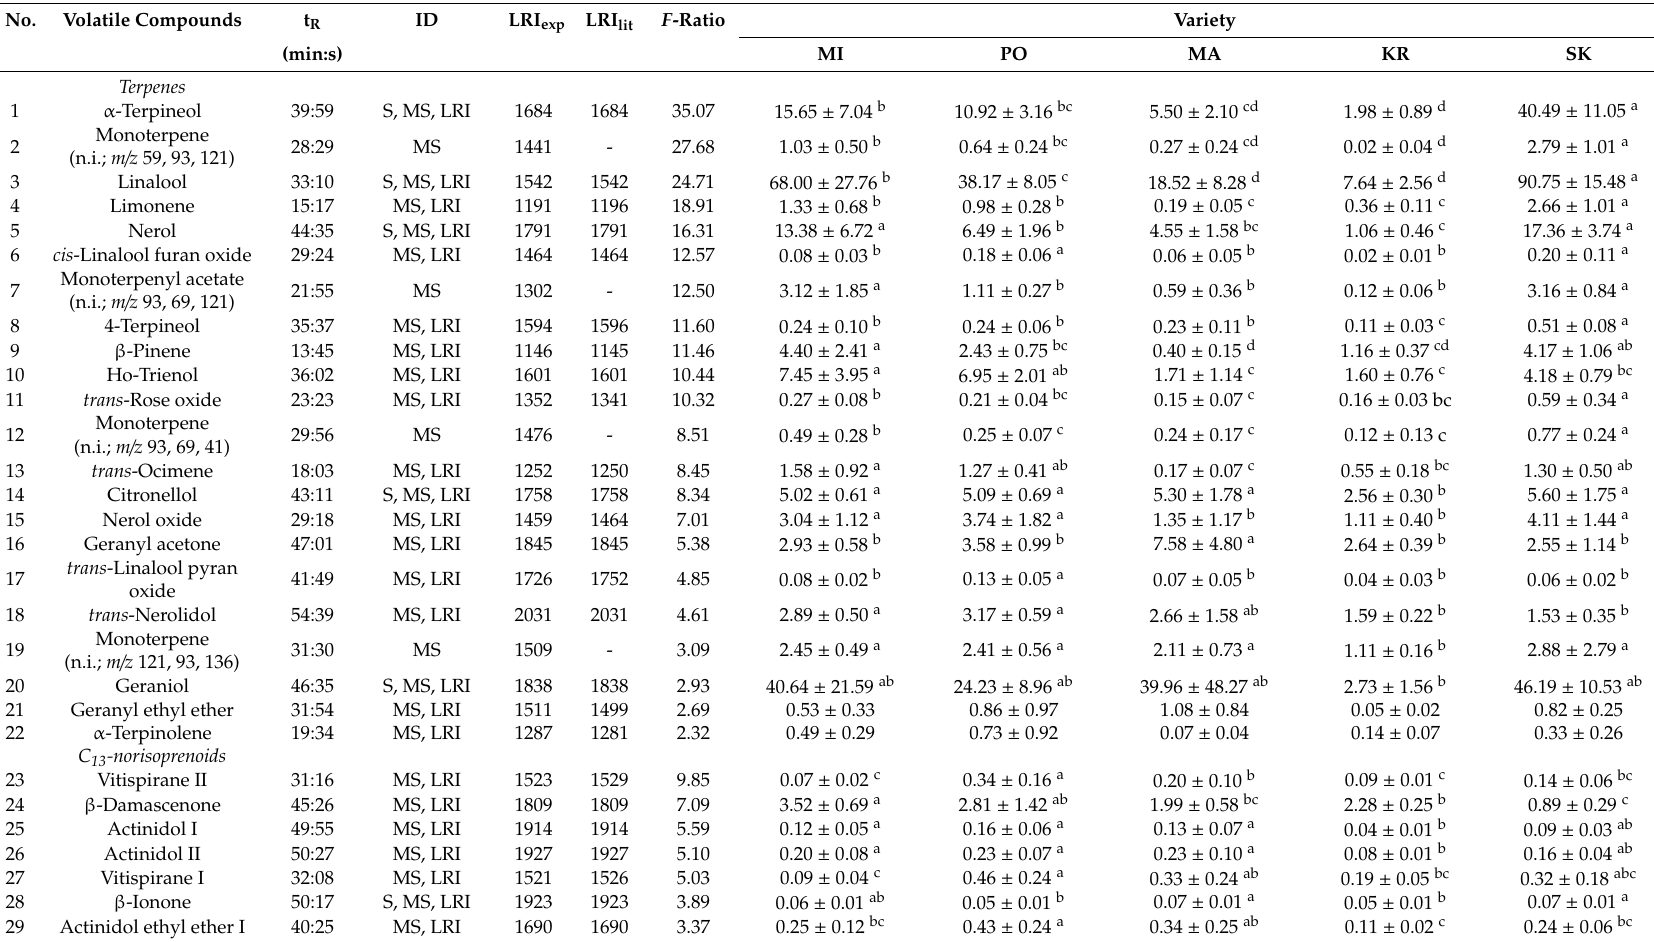
Table 1. Concentrations ( µ g / L) of volatile aroma compounds found in Croatian monovarietal wines after headspace solid-phase microextraction followed by gas chromatography-mass spectrometry (HS-SPME / GC–MS) sorted by compound class and descending Fisher F